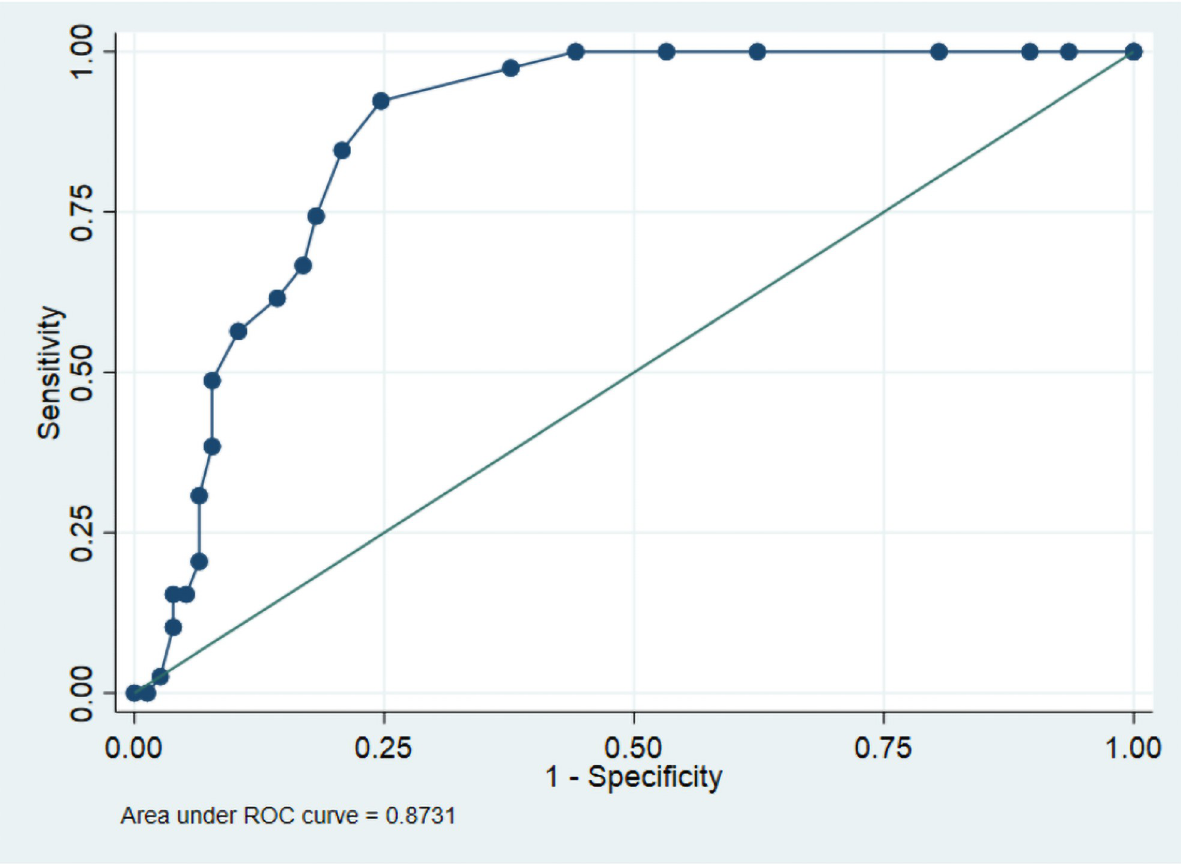
Fig 1. ROC curve of RUDAS for the identification of major neuro-cognitive disorder, 2020.